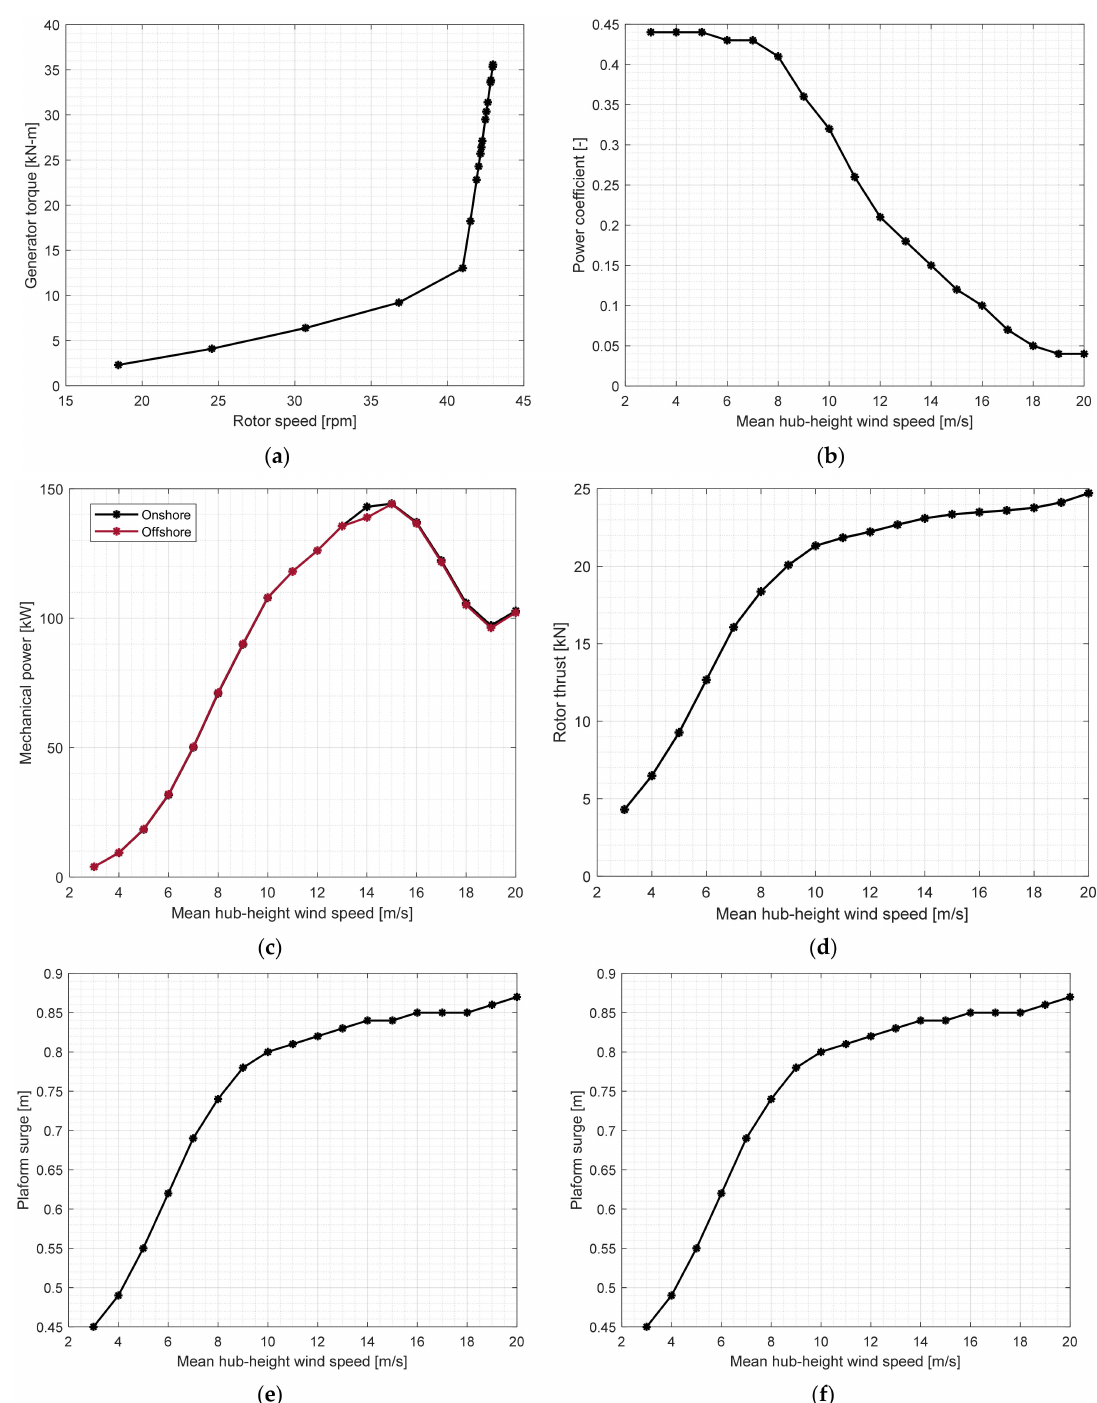
Figure 3. Torque–speed curve ( a ), response of power coefficient ( b ), generator power ( c ), rotor thrust ( d ), platform surge ( e ), and platform pitch ( f